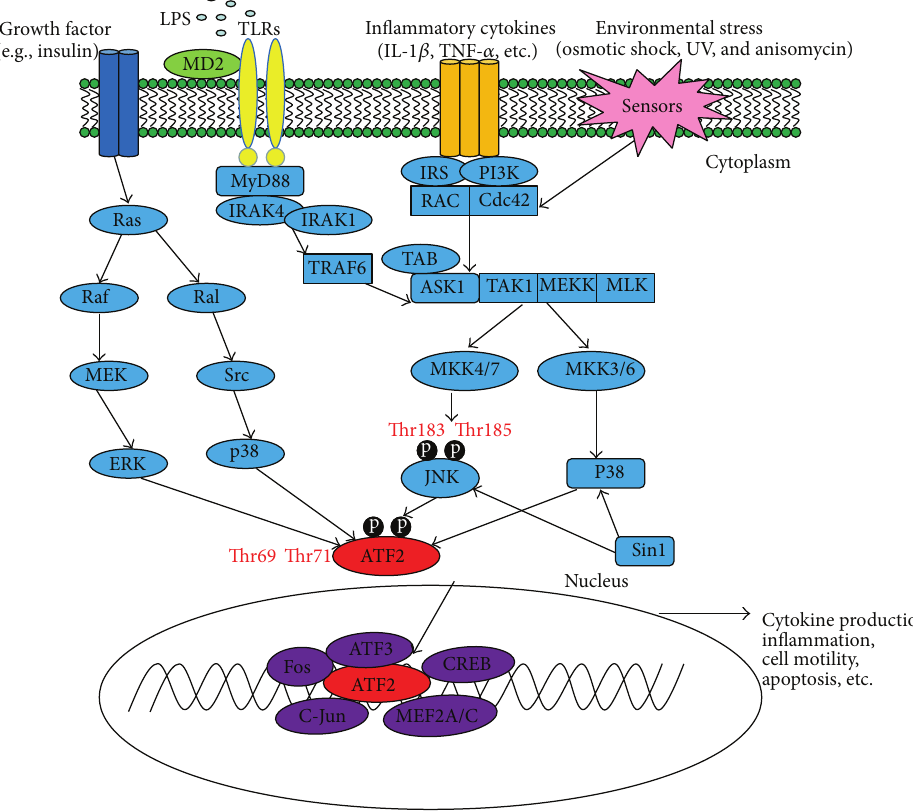
Figure 2: ATF-2-regulated signaling pathways in inflammatory